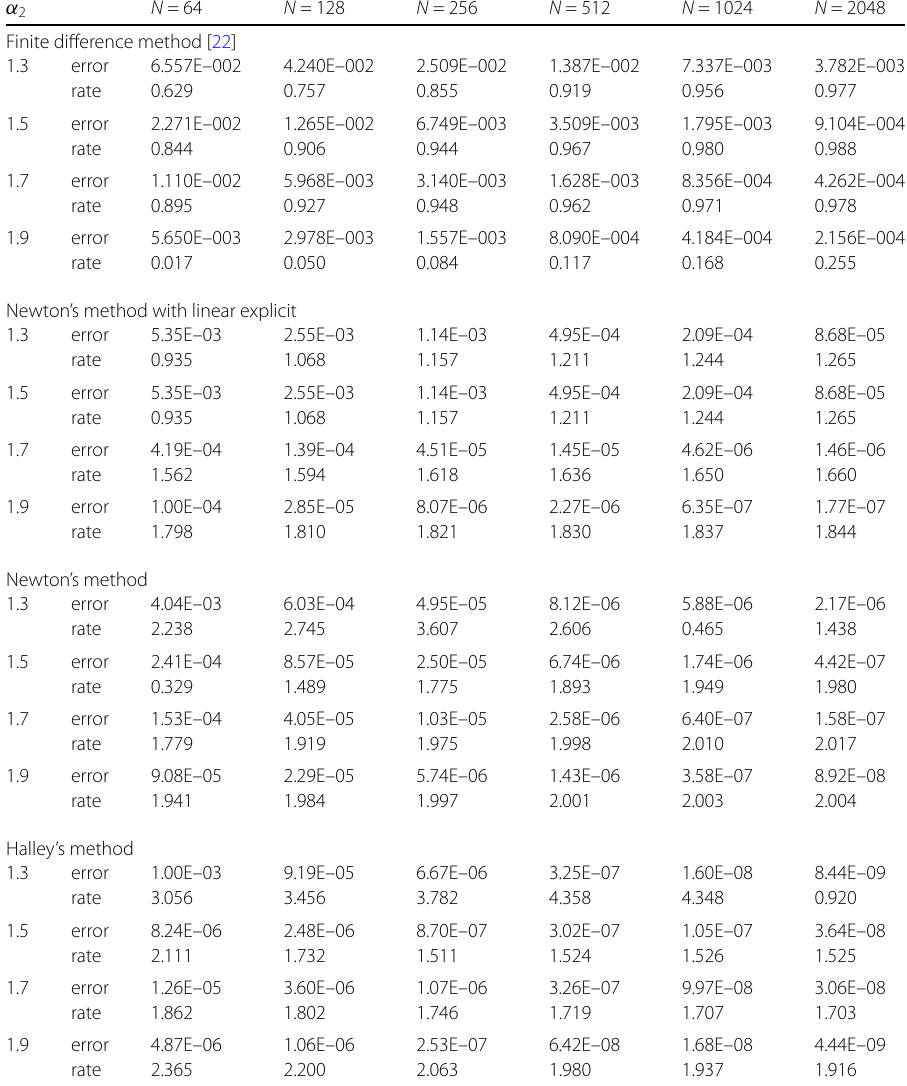
Table 12 The uniform two-mesh difference error and computed rates of convergence obtained by the proposed methods, Newton’s method, and Halley’s method. We set s 0 = 0.2, Tol = 10 –10 α 2 N = 64 N = 128 N = 256 N = 512 N = 1024 N = 2048 Finite difference method [22] 1.3